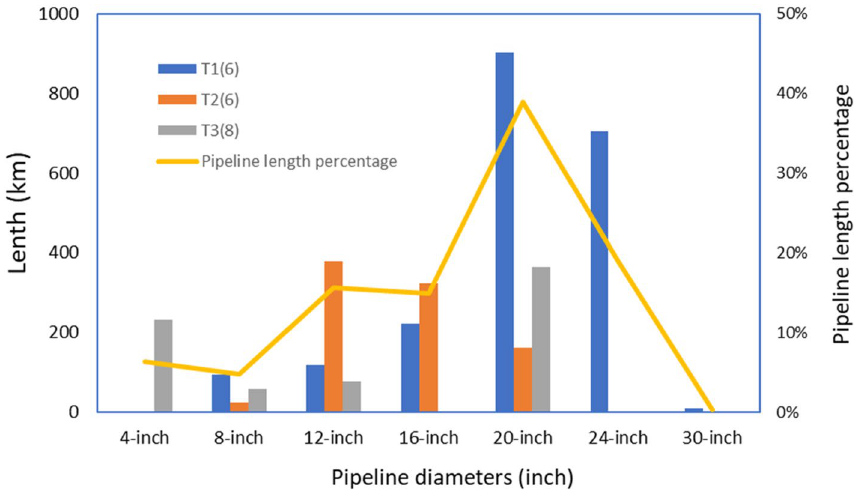
Figure 11. Lengths and diameters of the constructed pipeline for three intervals from the optimized solution for the I-WEST case